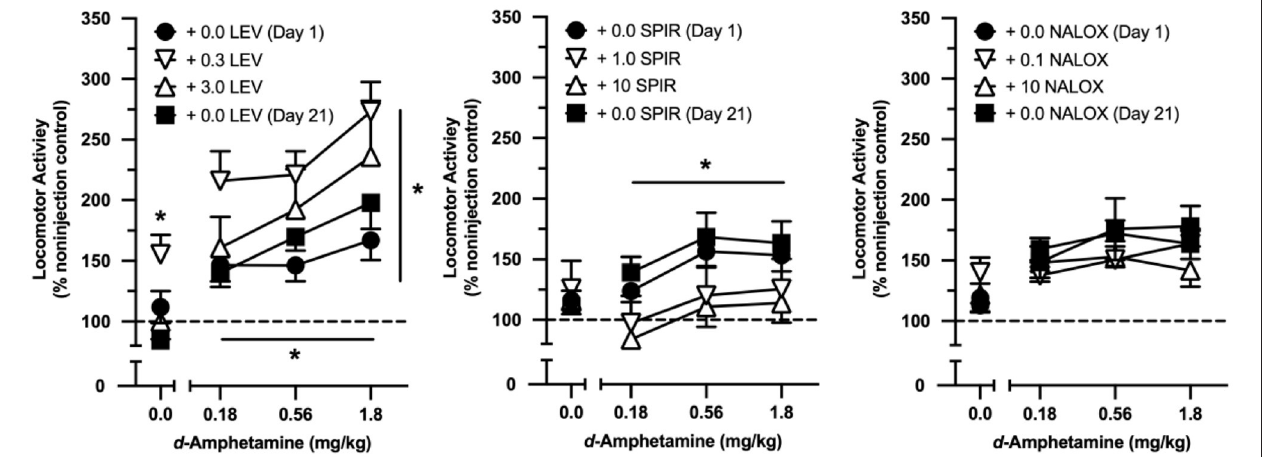
FIGURE 2 | Effects of cumulative doses of d -amphetamine when tested alone and when tested in combination with selected doses of levorphanol (LEV; n = 10), spiradoline (SPIR; n = 10), and naloxone (NALOX; n = 10). Vertical axes reflect locomotor activity expressed as a percentage of non-injection control values. Horizontal axes reflect dose of d -amphetamine in mg/kg. Points above “0” represent the effects of vehicle (saline) and various doses of opioids tested alone. Vertical lines represent the SEM; where not indicated, the SEM fell within the data point. Single asterisk indicates significant effect of opioid alone. Asterisk with horizontal line indicates significant effect of amphetamine dose. Asterisk with vertical line indicates significant effect of opioid